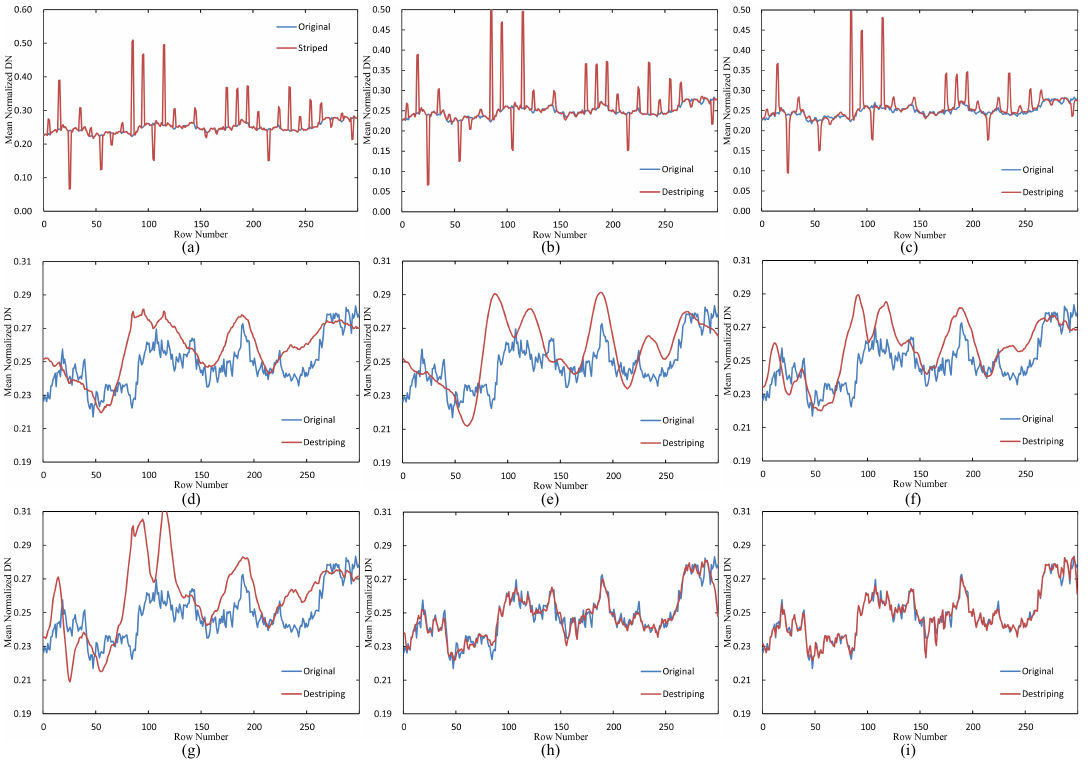
Figure 15. Mean cross-track profiles of comparison methods for simulated stripe Hyperion data